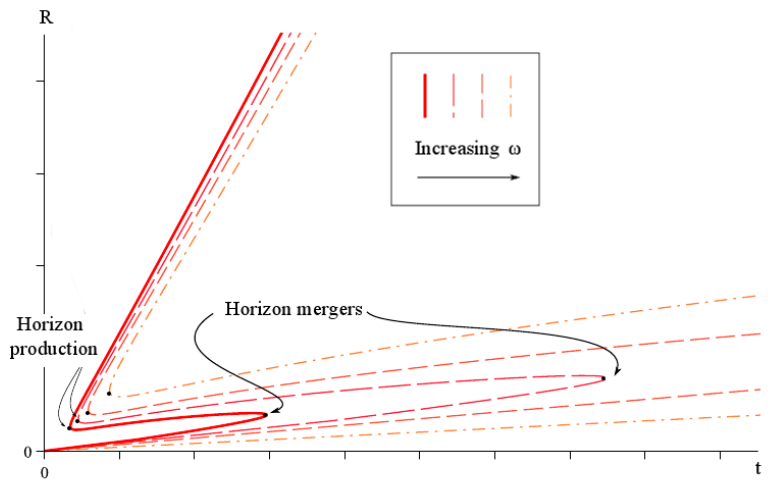
Figure 8. The areal radii of the apparent horizons as the value of the Brans-Dicke coupling ω increases. The lower bend of the S-curve is pushed to infinity as ω → ∞